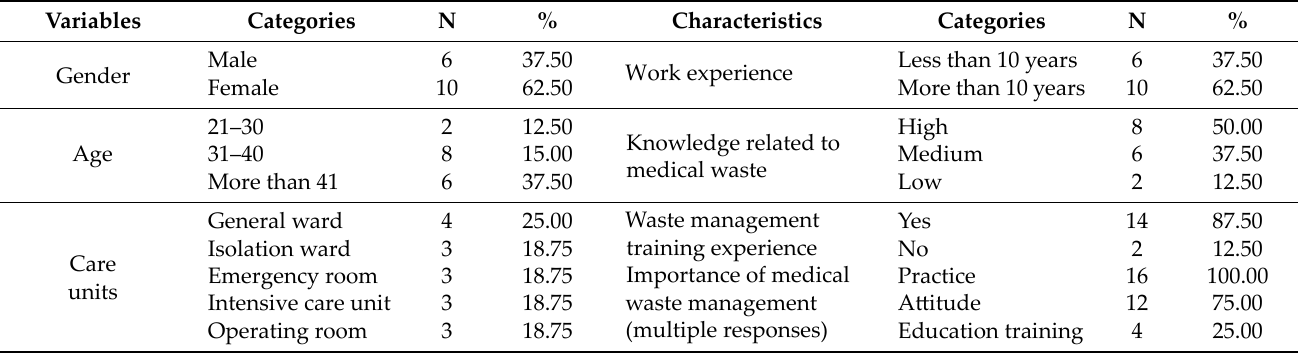
Table 4. Respondents’ demographic